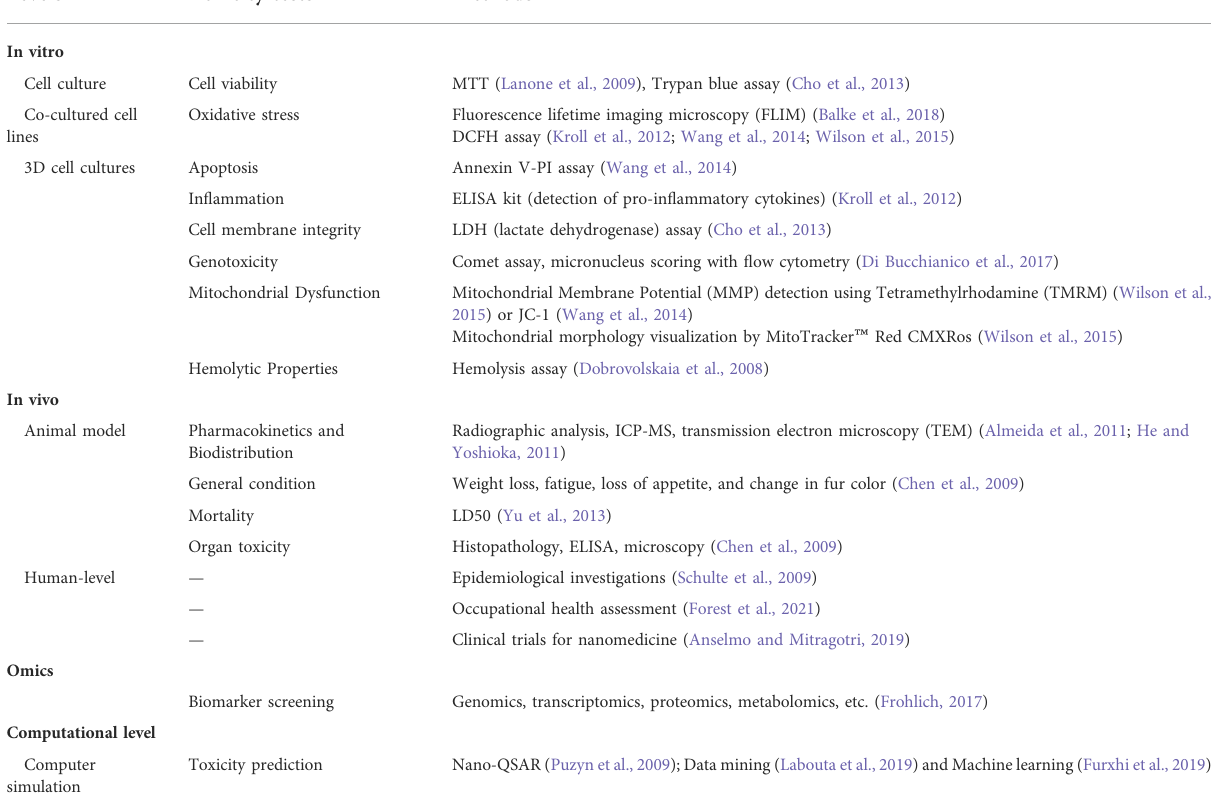
TABLE 1 Summary of some nanotoxicity assessment